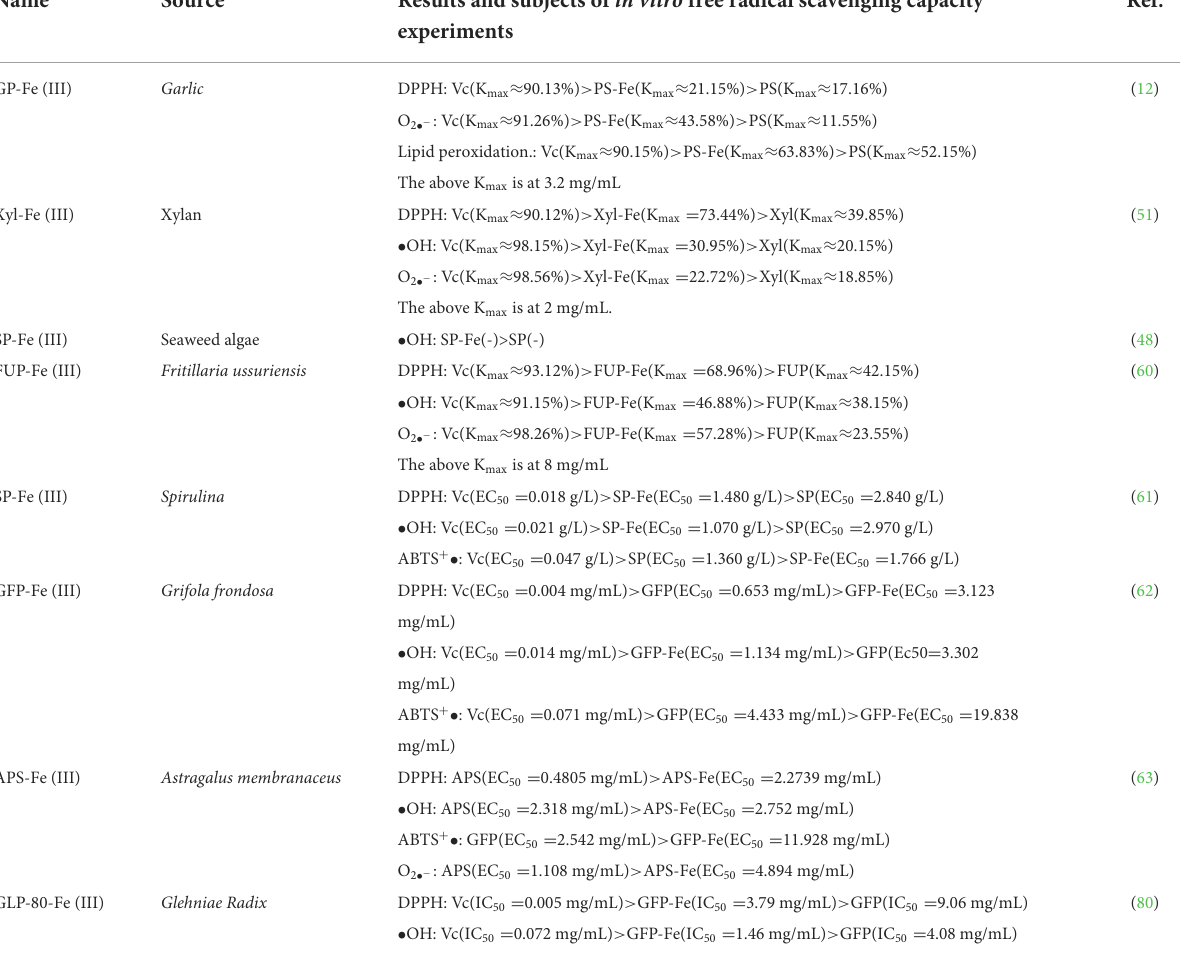
TABLE 3 In vitro antioxidant activity indexes and research results of